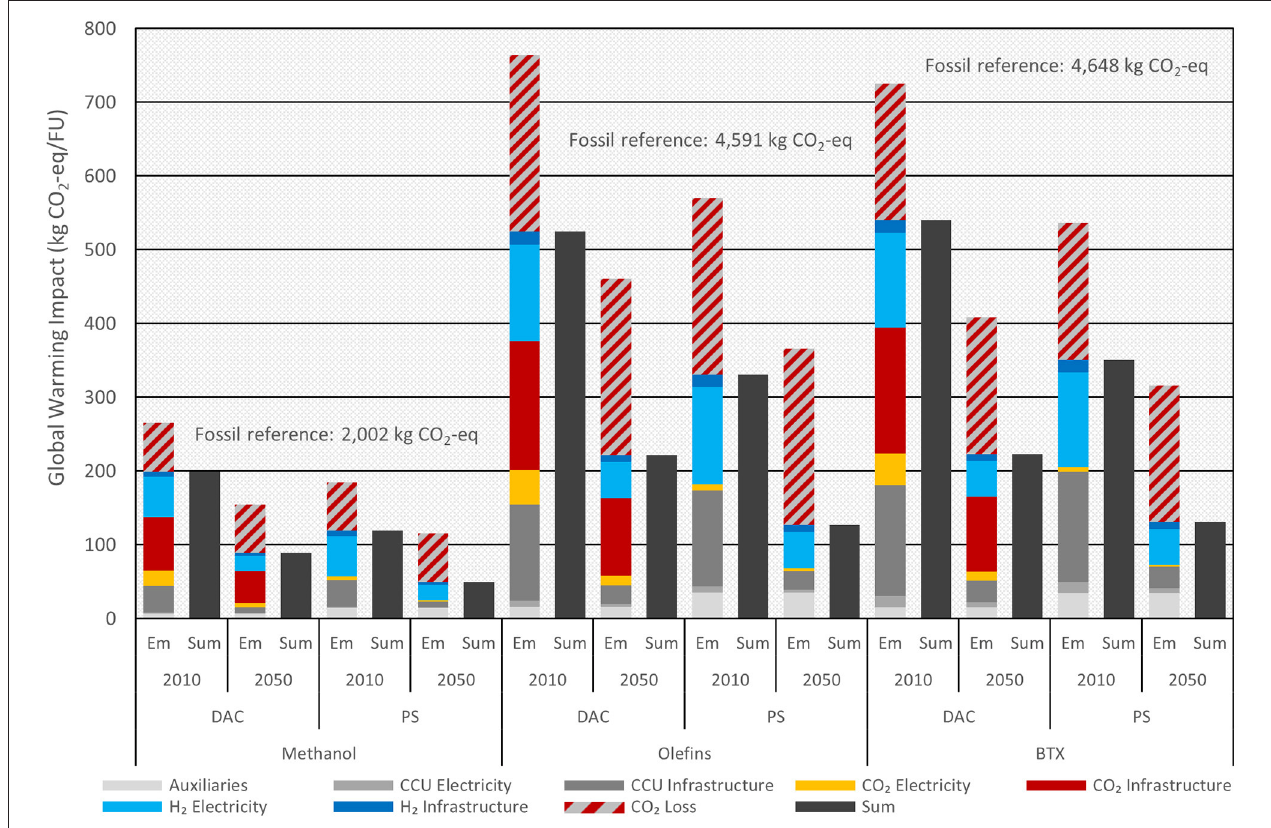
FIGURE 3 | 100:0 allocation approach. GWI for the production of methanol, olefins, and BTX from CCU technologies. Results are subdivided into direct air capture (DAC) and point-source (PS) scenarios with the current resource fabrication (2010) and an optimized, projected resource fabrication for the year 2050. Fossil reference values are out of scale and added separately, showing the large GHG reduction